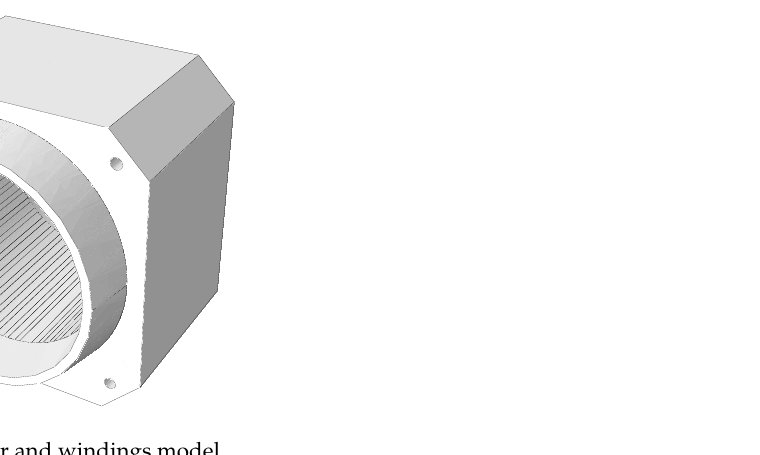
Figure 1. FEM stator and windings model.